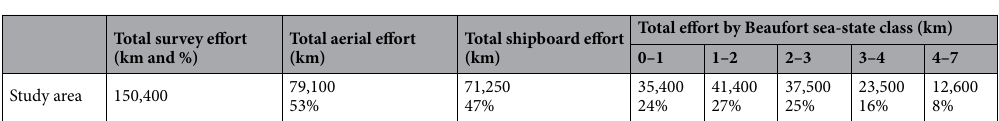
Table 2. Effort performed by platform type and Beaufort sea-state per sector in the North Atlantic Ocean. This table presents the total effort conducted in each sector broken down by platform type and Beaufort sea- state. Beaufort sea-state values reported with decimals in the surveys were rounded up. For the analyses, all segments with Beaufort sea-state > 4 were